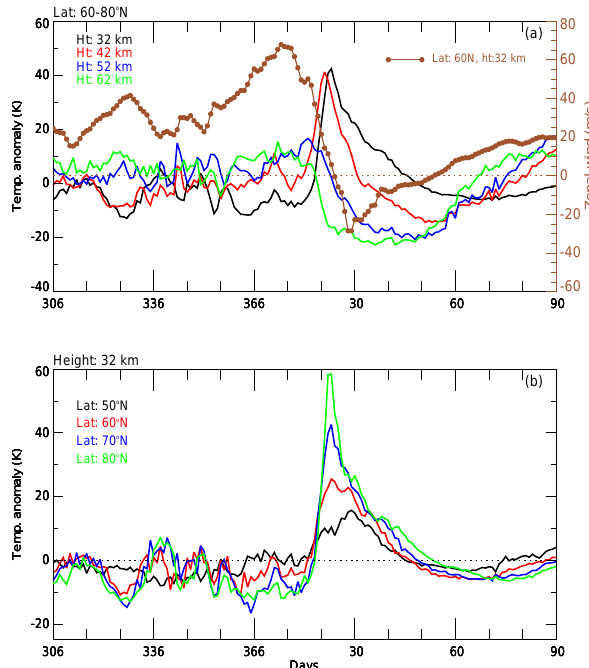
Fig. 1. (a) Daily MLS temperature anomalies at 32, 42, 52, and 62km altitude levels averaged for latitude range 60–80 ◦ N observed during November 2008 to March 2009. Zonal mean zonal wind from MERRA reanalysis over 60 ◦ N at 32km altitude level is also shown. (b) The latitudinal variability of the temperature anomaly at 32km altitude level for the latitudes 50–80 ◦ N is